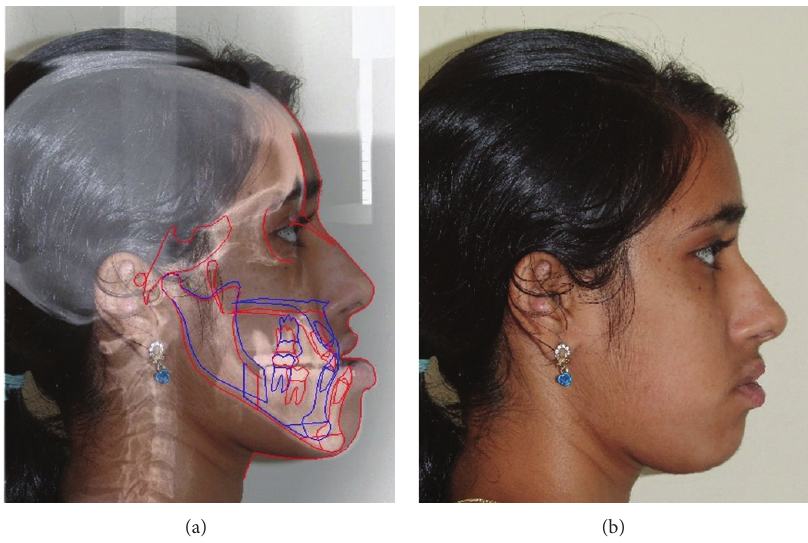
Figure 13: (a) Digital simulation of intended jaw movements (blue) and (b) predicted